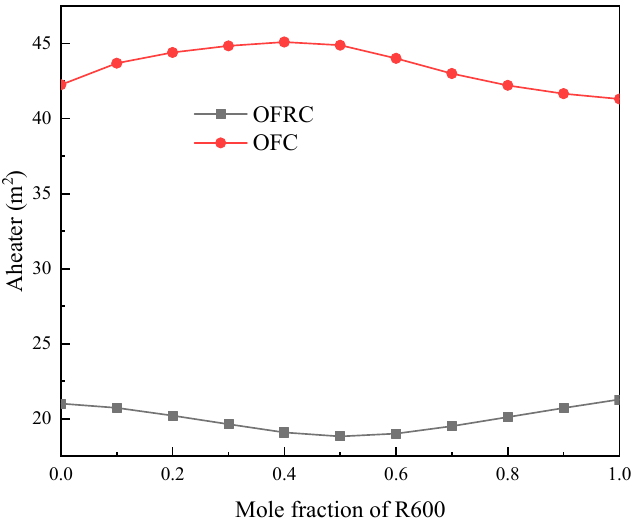
Figure 11. Variation of the heat exchange area of the system heater with the R600 mole fraction. Figure 12 shows the change in the heat exchange area of the system condenser with the R600 mole composition under the optimized operating conditions. With the increase in R600 mole component, the condenser of the OFRC system initially decreases, then increases, and finally decreases, whereas the condenser of the OFC system showed an opposite trend. When the R600 mole component is 0.5, the maximum condenser of the OFRC system is 50.66 m 2 . When the R600 mole component is 1, the condenser of the OFRC system is the smallest at 39.49 m 2 , and the relative reduction rate is 20.67% compared with the system with pure R245fa. When the R600 mole component is 0.2, the maximum condenser of the OFC system is 222.83 m 2 . When the R600 mole component is 0.7, the minimum condenser of the OFC system is 114.56 m 2 , when the R600 mole component is 1, the condenser of the OFC system is 124.65 m 2 , when the R600 mole component is 0, the condenser of the OFC system is 150.76 m 2 , compared with the systems with pure R600 system and pure R245fa, compared with the systems with pure R600 system and pure R245fa, the relative reduction rates are 8.09% and 24.01%, respectively. Furthermore, the condenser of the OFRC system is smaller than that of the OFC system. When the R600 mole component is 0.2, the maximum relative reduction rate of the condenser of the OFRC system is 79.02% compared with that of the OFC